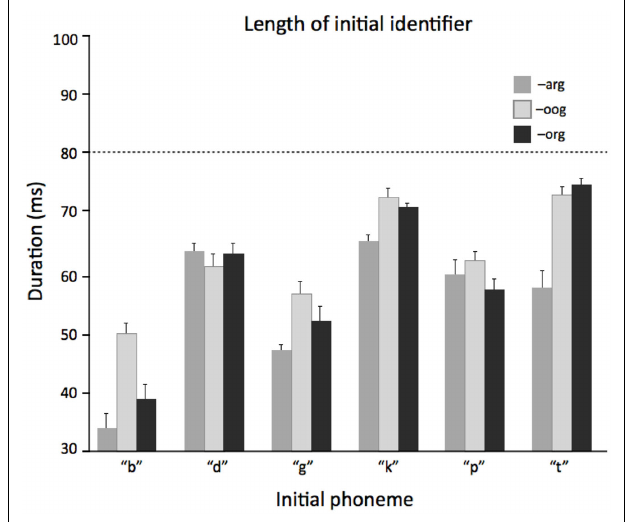
FIGURE 1 |The mean duration of the initial identifying sound for the group of five recordings of each of the possible pseudo-words. The dashed horizontal line at 80ms denotes the minimum time required to re-orient auditory spatial attention, as estimated byTeder-Sälejärvi and Hillyard (1998). All initial identifying sounds are less than 80ms in duration. Error bars are SE.